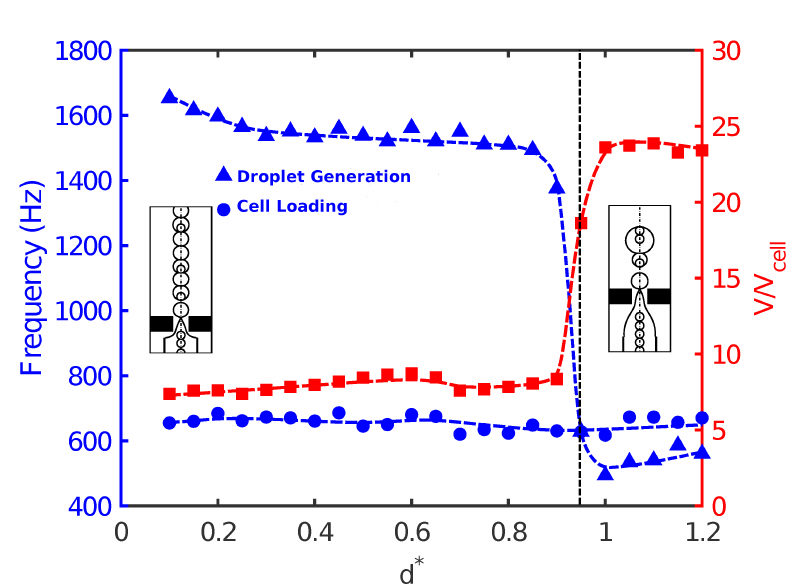
Figure 7. Frequency of droplet generation (triangles) versus frequency of cell loading (circles) and non-dimensional droplet size (squares) for configurations with different non-dimensional nozzle-to-orifice distances at Ca i = Ca o = 10 − 3 . Other geometrical parameters are kept fixed ( r ∗ = 0.25 and l ∗ = 0.5).